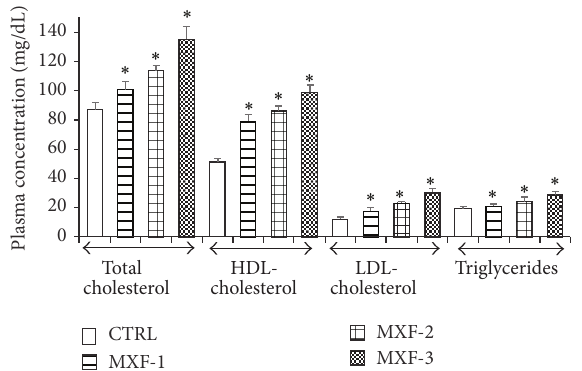
Figure 2: Influence of MXF on plasma lipid profile of rat. Values represent the mean ± SD of six replicates. ∗ Significantly different from control ( 𝑃 < 0.05